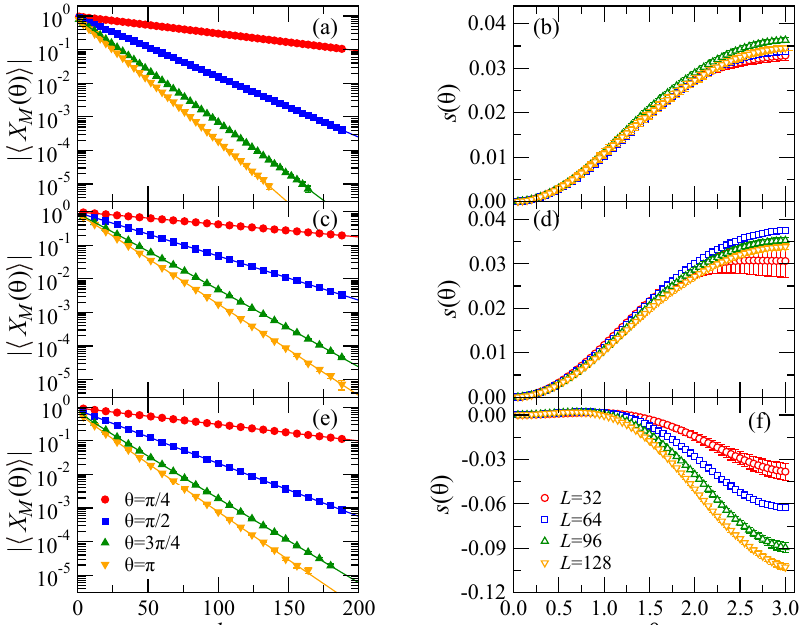
( θ ) 〉| as a function of the perimeter l = 4 R − 4 Figure 2: Disorder parameter |〈 X M with system size L = 96 at the QCPs for H model (a), H model (c) and J 1 − J 2 bilayer the H model (e). (b), (d) and (f) show the obtained s ( θ ) with system size J − Q 3 L = 32,64,96,128 for the three models in (a), (c) and (e), respectively. The conver- gence of the data with increasing L is clear from the